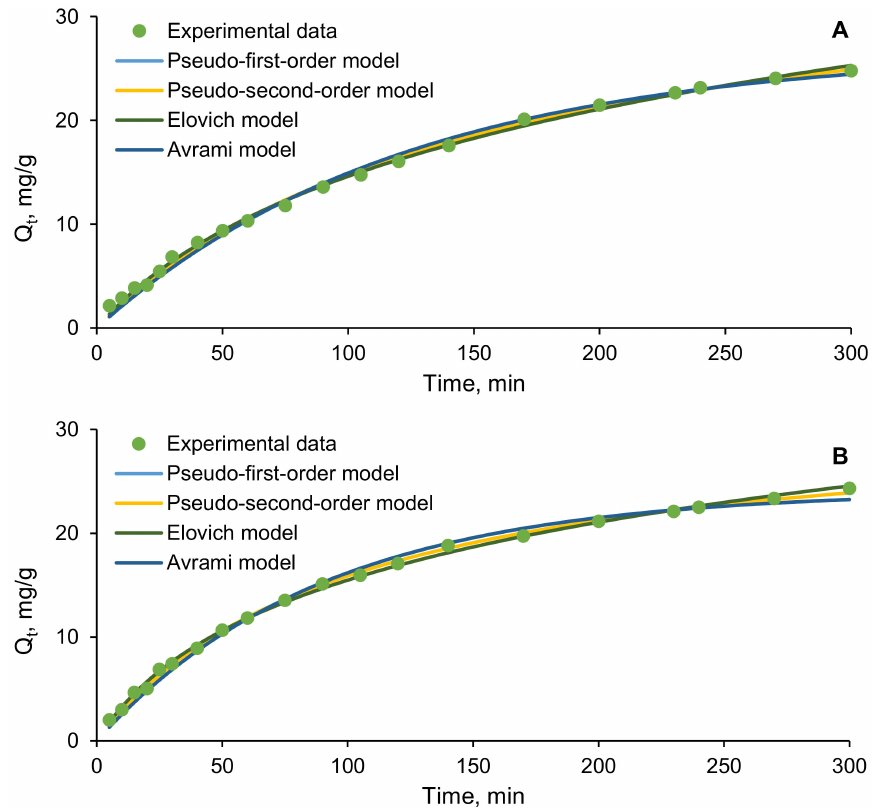
Figure 7. Kinetic models for the biosorption of EL on synthesized biosorbents (( A )—SPA 5%; ( B )—SPRBA 5%) ( Q t —concentration on the solid phase at time t